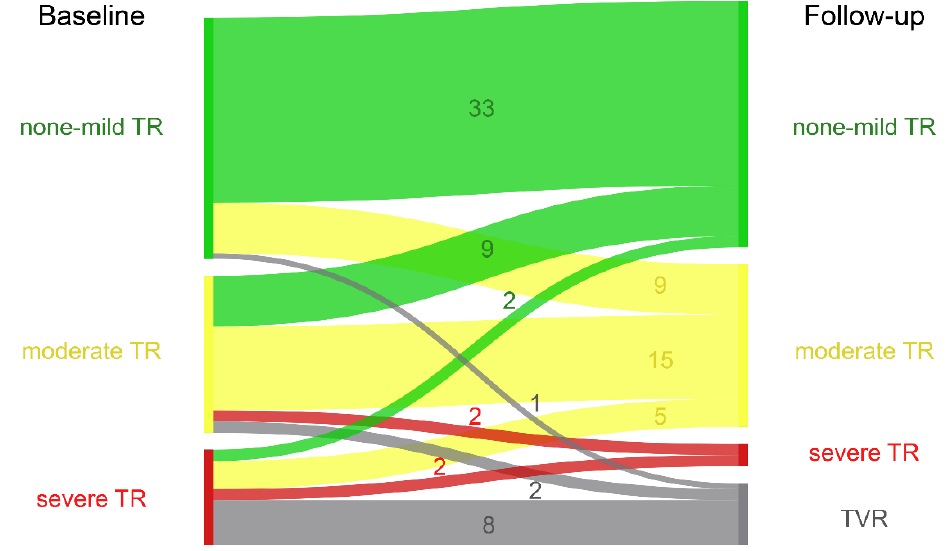
Figure 3. Sankey diagram of tricuspid regurgitation at baseline and follow-up. New atrial arrhythmias occurred in 11 patients (11.8%), while ventricular tachycardias were present in 9 (9.7%). A new pacemaker was implanted in 18 patients (19.4%), while complete heart block developed in 6 (6.5%). Catheter interventions were necessary in 12 patients (12.9 %) and electrophysiological ablations in 13 (14.0%). Hospitalizations due to heart failure occurred in 48 patients (51.6%). Three patients received a heart transplantation; two out of these died during the postoperative course after the transplantation. The primary endpoint occurred in 10 patients (10.8%). Cause of death was cardiac in nine patients and suicide in one.